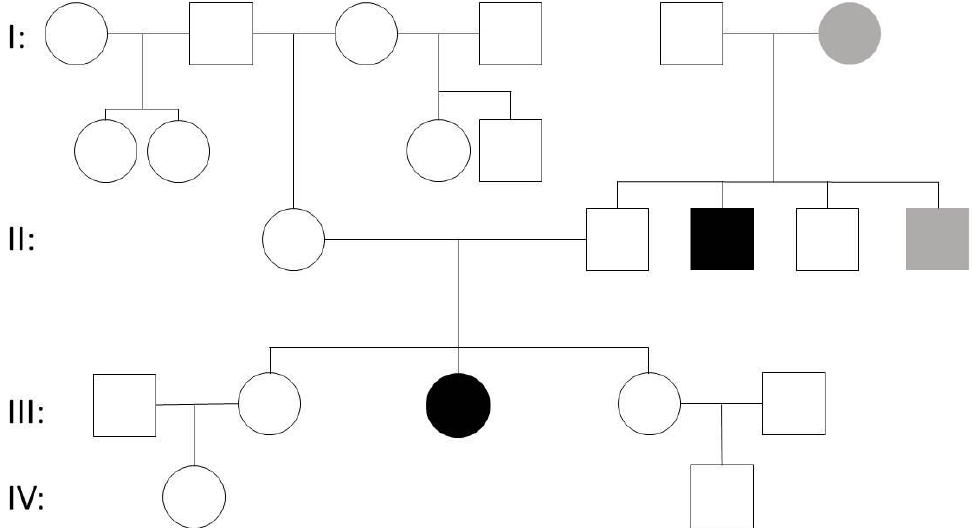
Figure 1. Pedigree of case 2. Please note that not only the index patient (III:3), but also her healthy father (II:2) and one healthy sister (III:2) harbor the KCNH1 nonsense mutation p.Arg535*. Two brothers of the father (II:3 (intellectual disability) and II:5 (CNS tumor)) and the paternal grandmother (I:6 (CNS tumor)) of the index patient have a known history of CNS disorder.